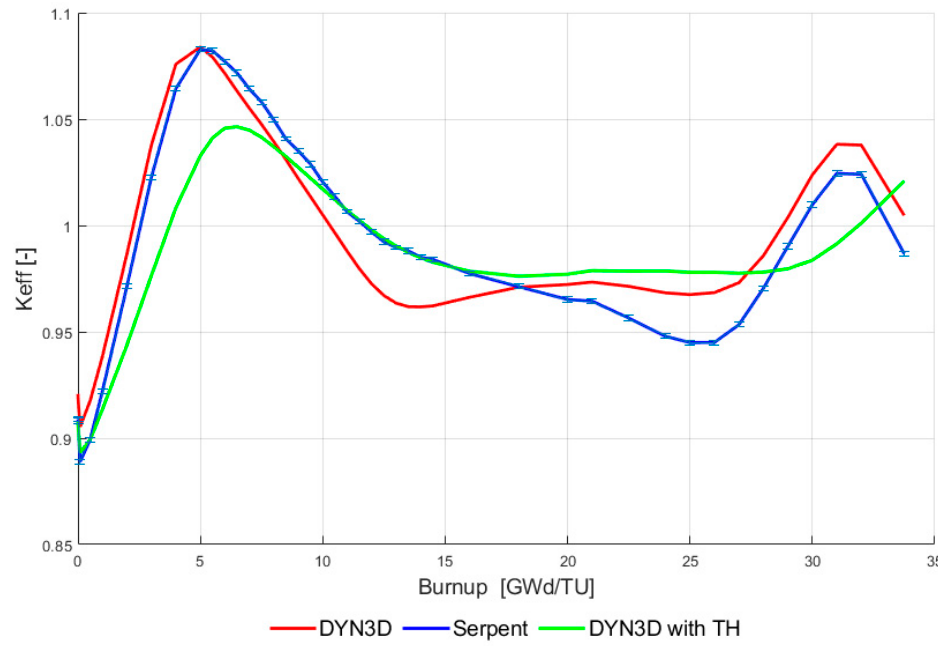
Figure 21. Fuel assembly one fuel burnup comparison between DYN3D and Serpent.